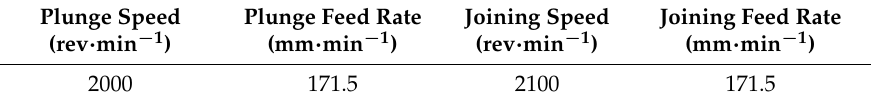
Figure 4. Assembled FBJ specimen: ( a ) lap shear specimen and ( b ) cross-tension specimen. Table 4. FBJ welding process parameters for joining of CFRP to Table 4. FBJ welding process parameters for joining of CFRP to DP980. Table 4. FBJ welding process parameters for joining of CFRP to DP980.